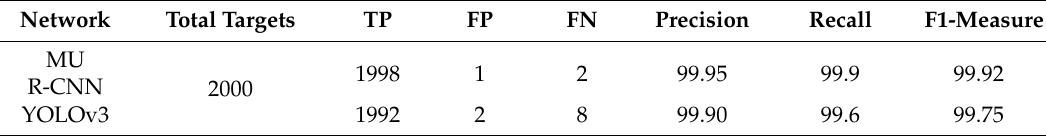
Table 9. Comparison of the e ff ects of MU R-CNN and YOLOv3 in UAV environment.